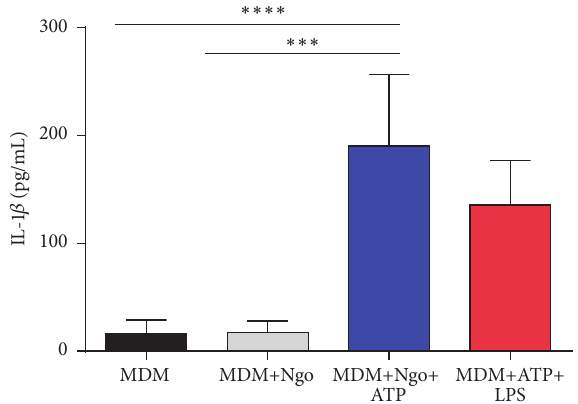
Figure 2: ATP treatment increases IL-1 𝛽 levels by Ngo-infected MDM. MDM cells were infected with Ngo and then treated with ATP (5 mM) for 30 minutes. Culture supernatants were collected for measurement of IL-1 𝛽 by ELISA. Data represent at least 4 independent experiments; bars indicate SD; ∗∗∗ 𝑃 < 0.001 ; ∗∗∗∗ 𝑃 < 0.0001